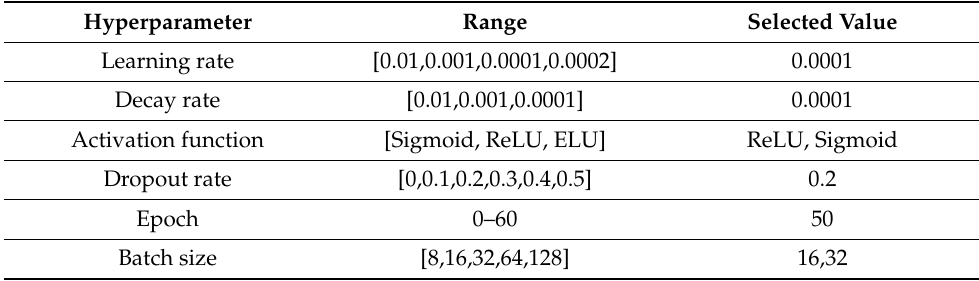
Table A3. Hyperparameters of our